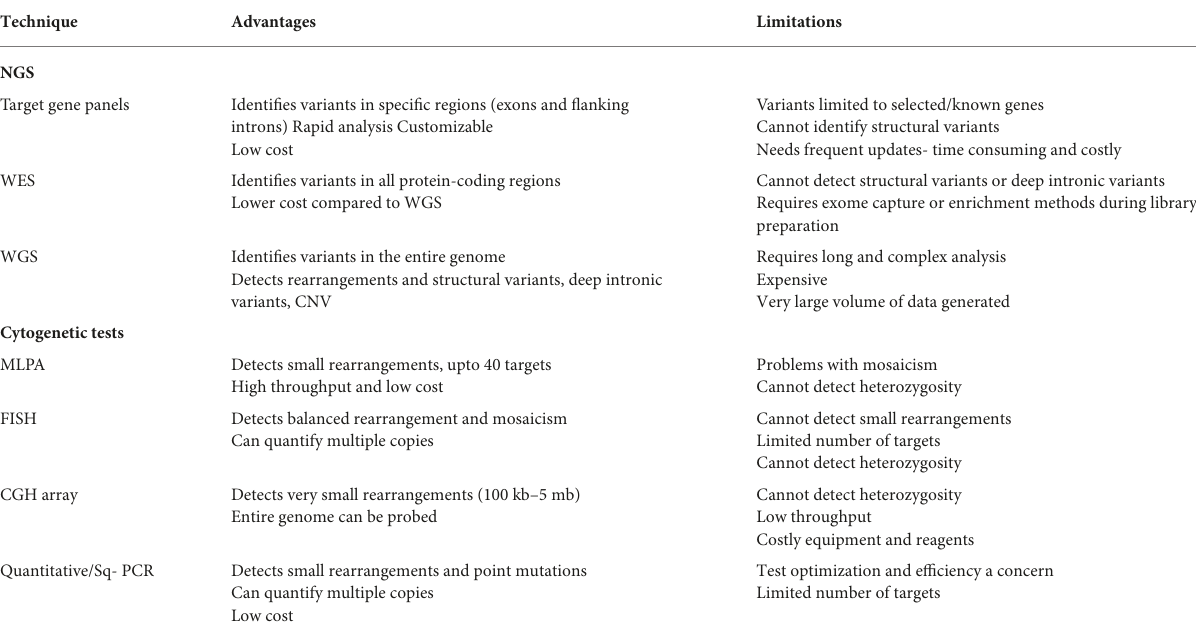
TABLE 3 Advantages and limitations of various genetic testing